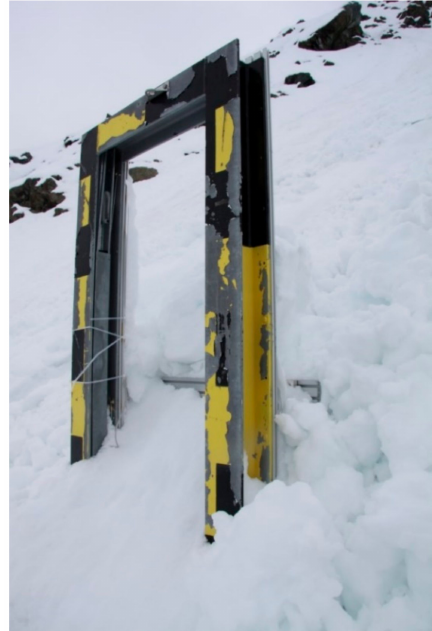
Figure 13. View of the obstacle after the event on 30 April 2014 (photo M. Maggioni on May 1). It is clearly visible that the plates are totally submerged in the snow and the large snow agglomerate against the structure.